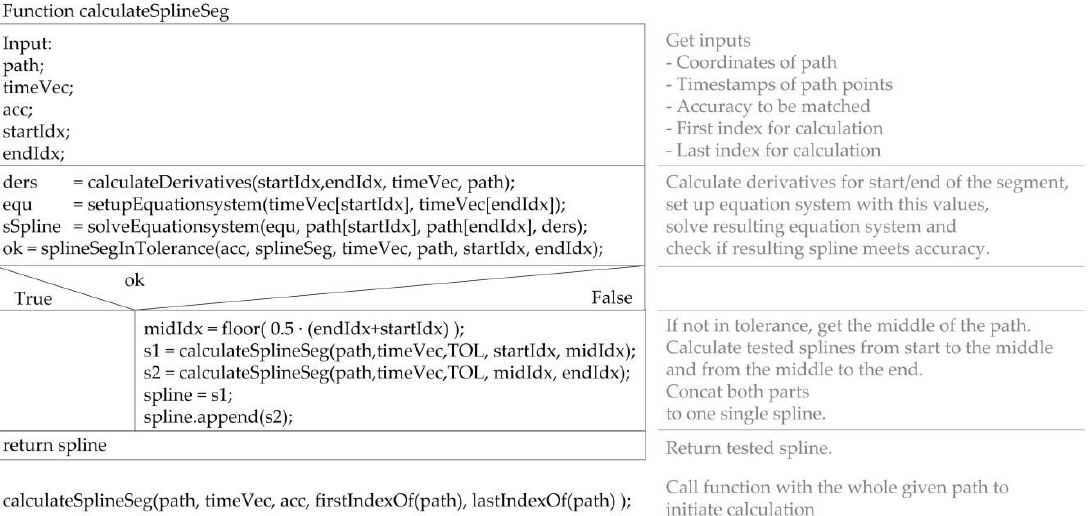
Figure 5. Monomial spline-based iterative algorithm msITER.